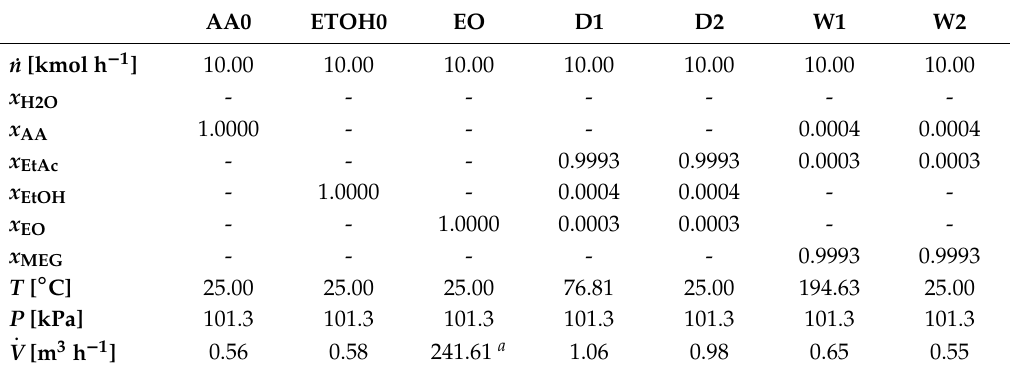
Table 7. Material balance of designed RD column with an auxiliary reaction (Figure 4).